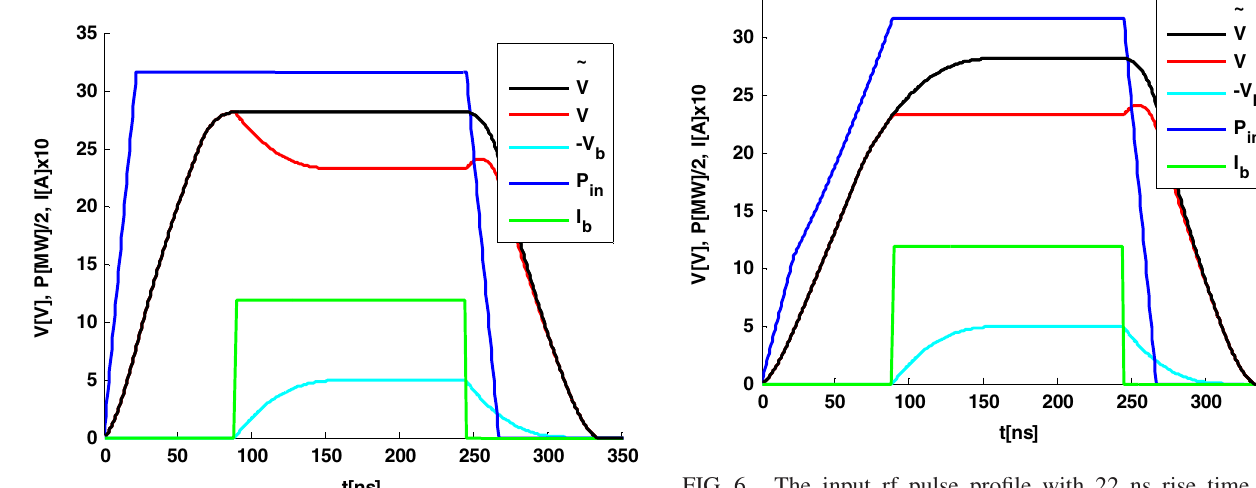
FIG. 6. The input rf pulse profile with 22 ns rise time and ramp-up during the filling time for the transient beam loading compensation is shown in blue. Beam current injected exactly at the end of the ramp is shown in green. The corresponding unloaded, loaded, and beam voltages are shown in black, red, and light blue,